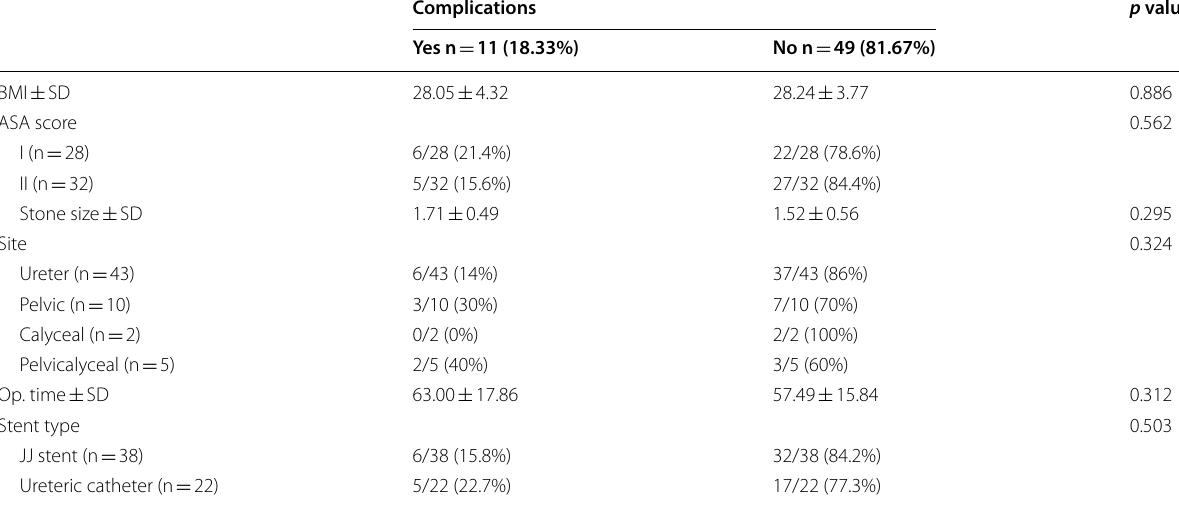
Table 5 Comparison between baseline patient characteristics, operative parameters and complication rate